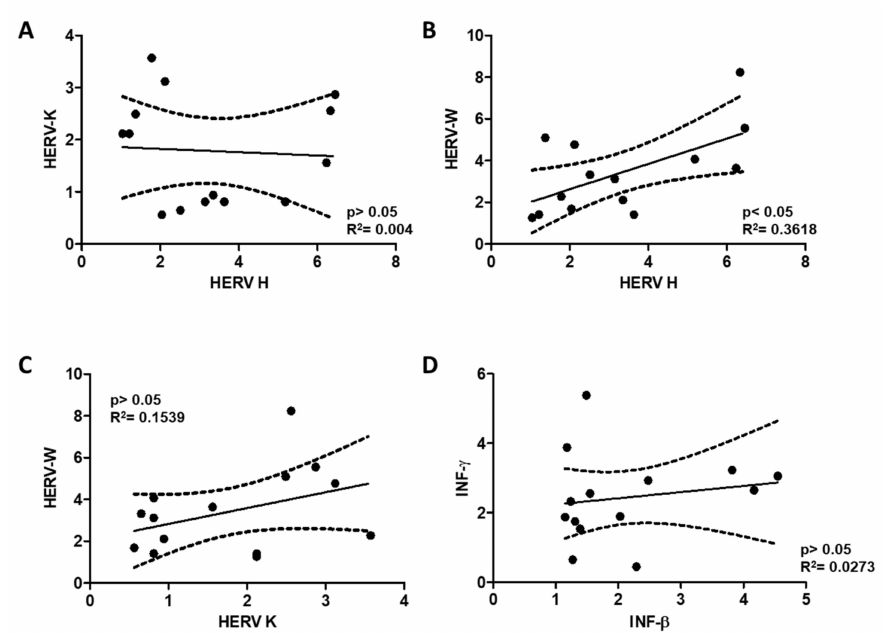
Figure 4. Linear regression analysis of HERV-H, HERV-K and HERV-W levels with respect to each other ( A – C ); and correlation between INF- β and INF- γ levels ( D ) in PBMCs of FM patients are shown. Adjusted calculated best-fit lines together with SD values (dotted lines) are represented for each data set pair; R 2 and p values are